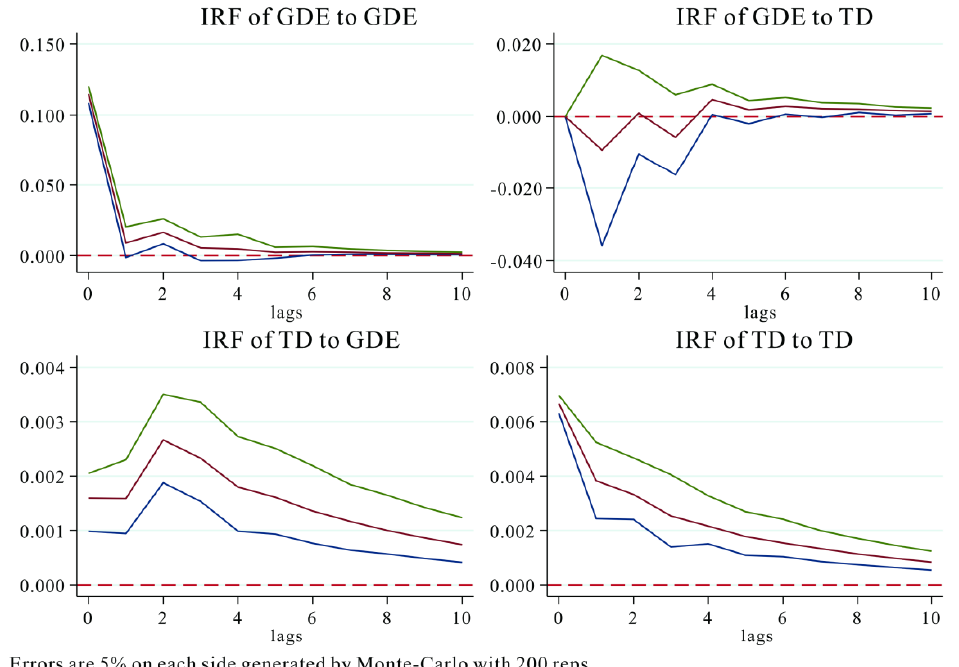
Figure 4. Impulse response relationship between TD and GDE. Note: The red line is the impulse response curve, the green and blue lines represent the 5% and 95% quantile lines.